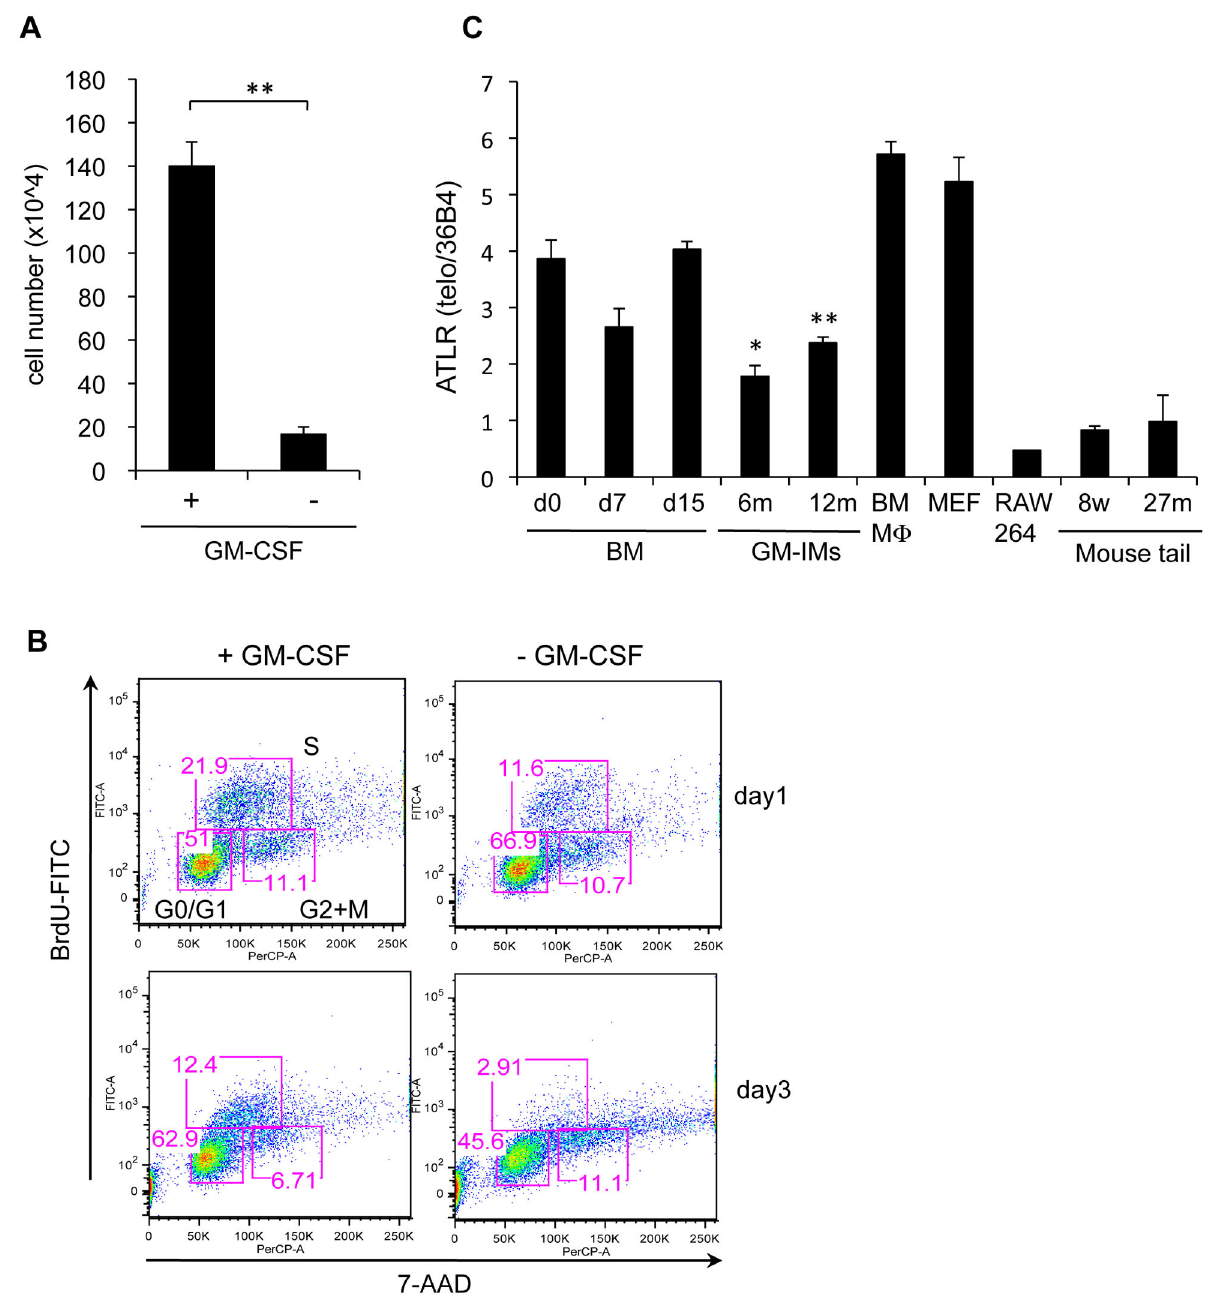
Figure 2. Continuous proliferation of GM-IMs was dependent upon GM-CSF. GM-IMs were plated in ten cm non-coated plastic dishes. They were cultured in RPMI-1640 supplemented with 10% FBS with or without 10% GM-CSF-CM. (A) GM-IMs (3x10 5 ) were cultured in ten cm non-coated dishes and after six days of culture, the cell number was counted by trypan blue dye exclusion. Data shown are the mean ratios ± SE of four independent experiments. P value: **<0.001. (B) On days one and three of culture, cells were stained with BrdU-FITC and 7-AAD and analyzed by flow cytometry. Data are representative of three independent experiments. (C) Comparison of the average telomere length ratios (ATLR) between BM cells cultured in 10% GM-CSF-CM for the indicated times during which cells became GM-IMs and indicated cells or murine tails. Data shown are the mean ratios ± SE of three independent experiments. P value: *<0.01, **<0.001 in comparison to that of tail from 8 weeks old murine.